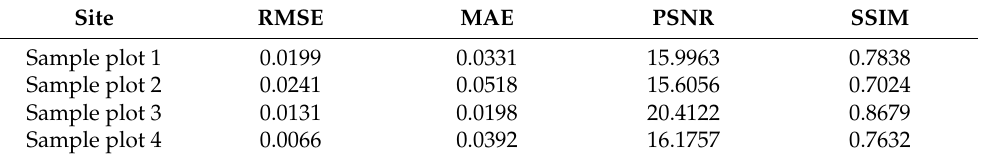
Table 4. Accuracy assessment of reconstructed NDVI model based on